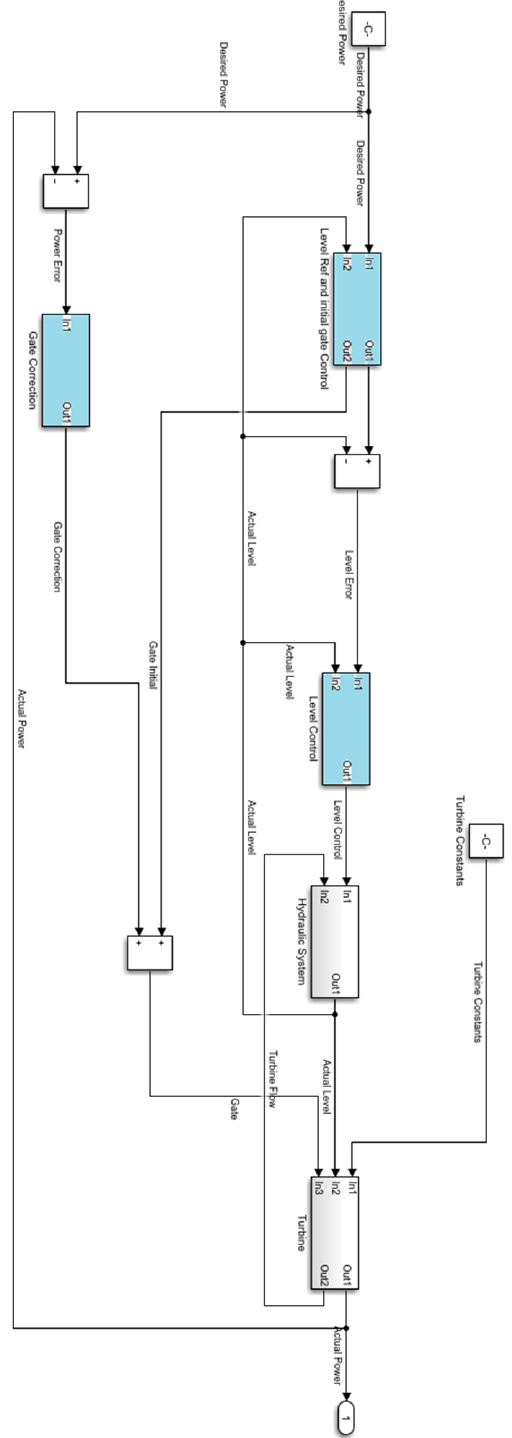
Figure 2. Control scheme for the system showing three different controllers (in color).